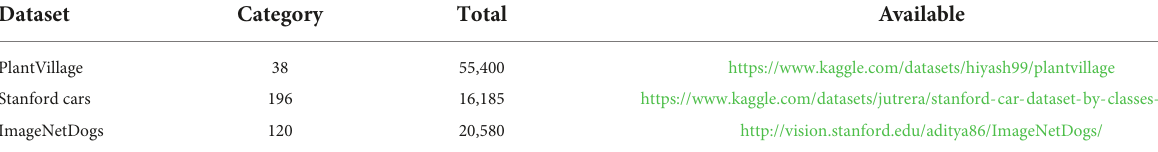
TABLE 12 Public dataset details.